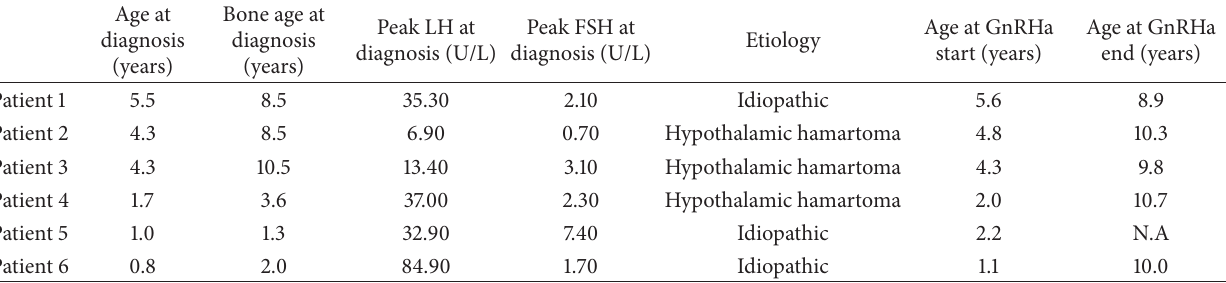
Table 1: Characteristics of boys with central precocious puberty included in this